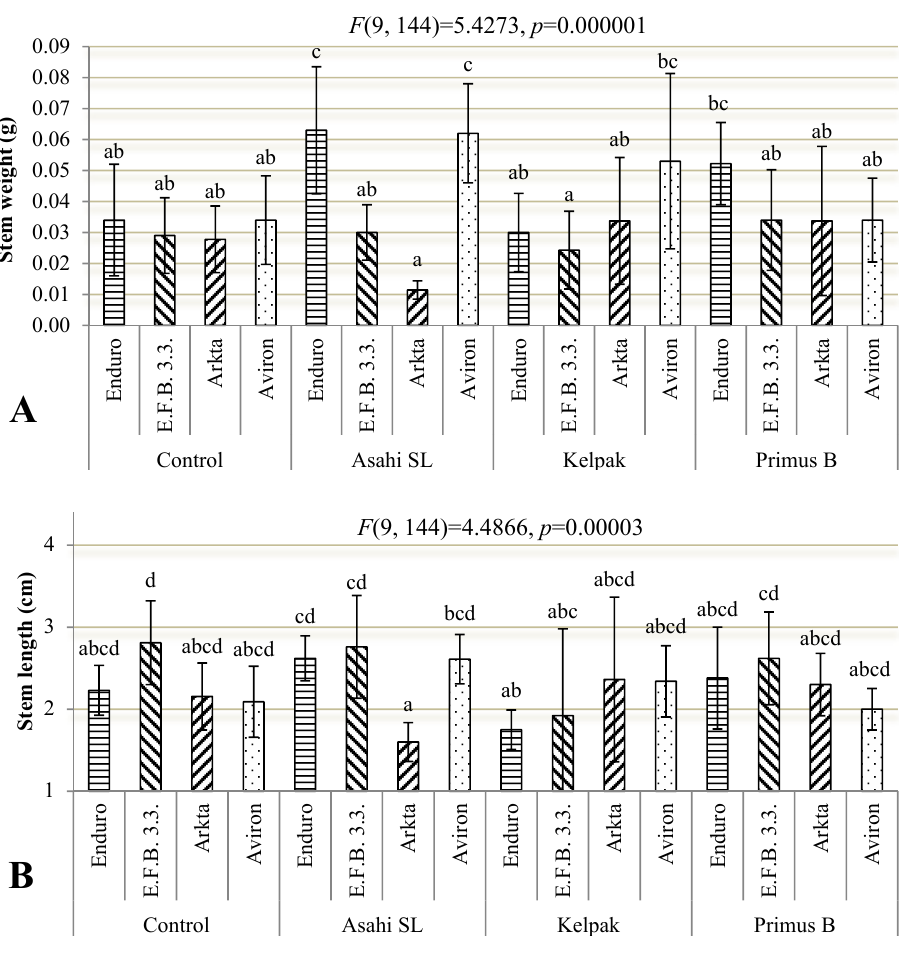
Fig. 2 The interaction of the cultivar and biostimulator in the assessment of the ( A ) weight (g) and ( B ) length (cm) of stems of winter pea seedlings. Different letters indicate differences between means significant at p < 0.05 according to Tukey’s HSD